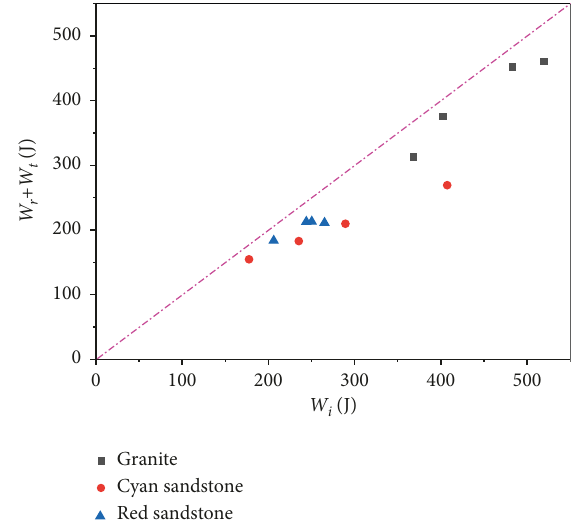
Figure 8: Variations of unused energy of different types of